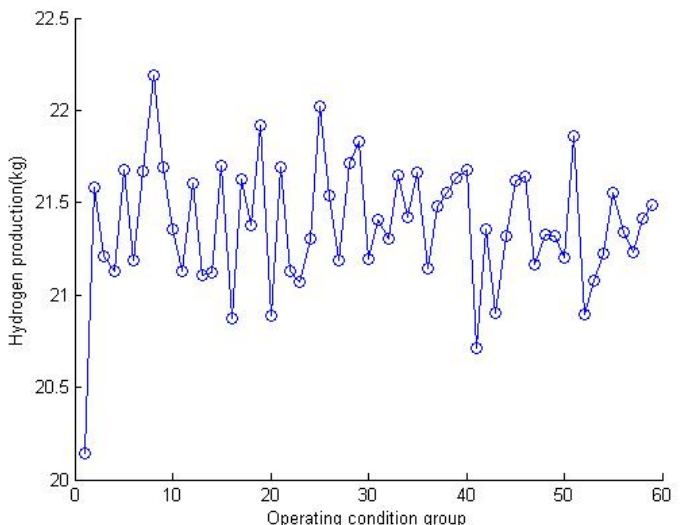
Figure 9. Scatter diagram of hydrogen production in 38 mm LOCA.